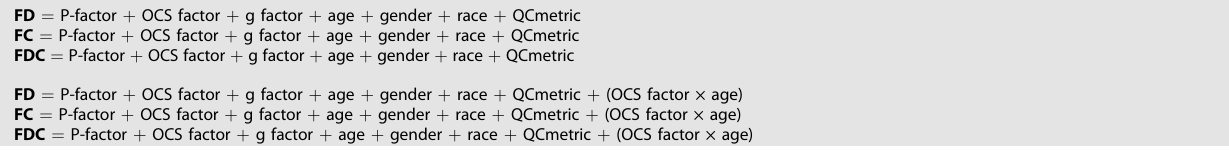
Box 3. The models examining fi xel-based correlates of the four OCD symptom domain factor scores, with all covariates FD = P-factor + Bad Thoughts + Repetition/Checking + Symmetry + Contamination + g factor + age + gender + race + QCmetric FC = P-factor + Bad Thoughts + Repetition/Checking + Symmetry + Contamination + g factor + age + gender + race + QCmetric FDC = P-factor + Bad Thoughts + Repetition/Checking + Symmetry + Contamination + g factor + age + gender + race +